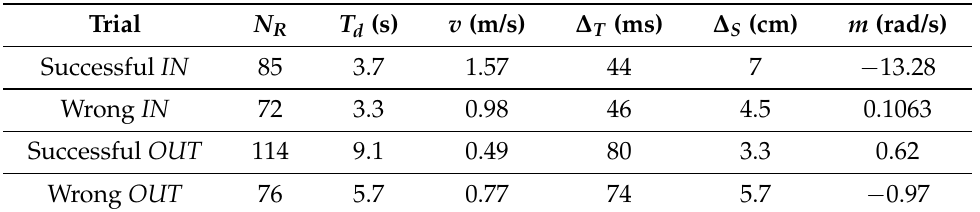
Figure 12. Examples of measured normalized unwrapped phase φ n [ n ] . ( a ) Successful IN classification, ( b ) wrong IN classification, ( c ) successful OUT classification, ( d ) wrong OUT classification. Table 1. Main features of the trials represented in Figure